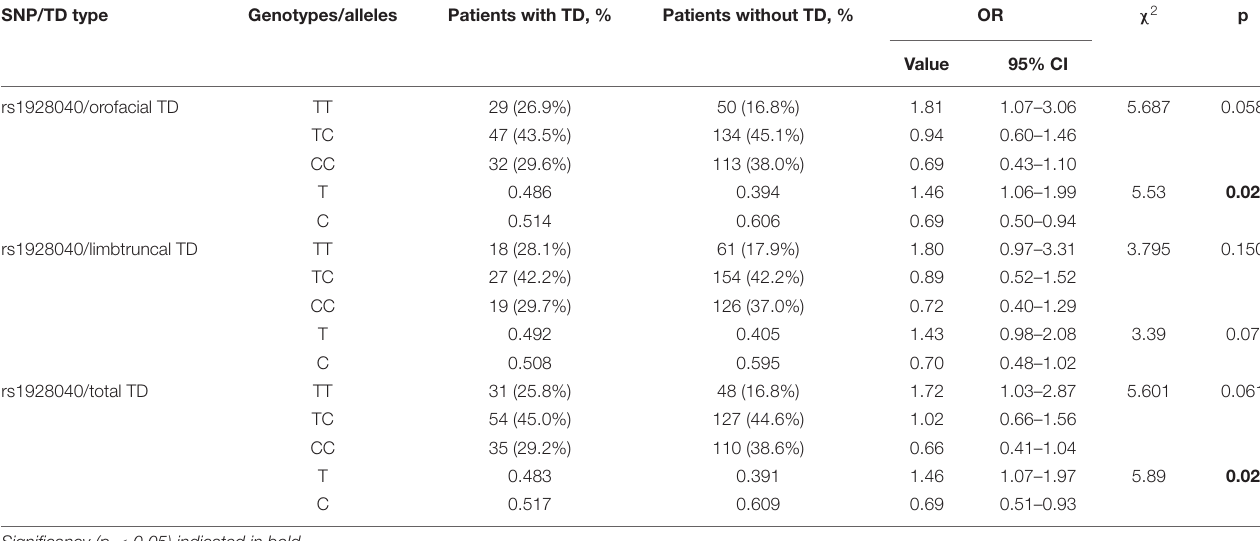
TABLE 2 | Results of association analysis for genotypes and alleles of rs1928040 between groups of patients with different types of tardive dyskinesia and without tardive dyskinesia. SNP/TD type Genotypes/alleles Patients with TD, % Patients without TD, %